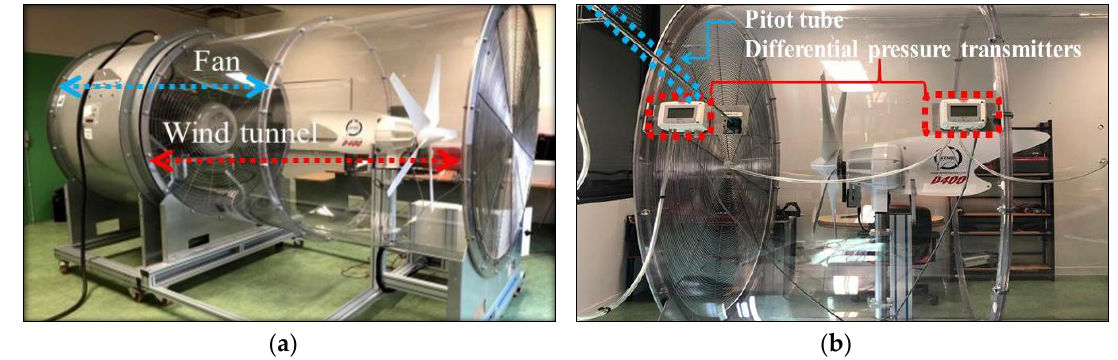
Figure 2. ( a ) Wind tunnel; ( b ) pressure transmitters and Pitot tube.